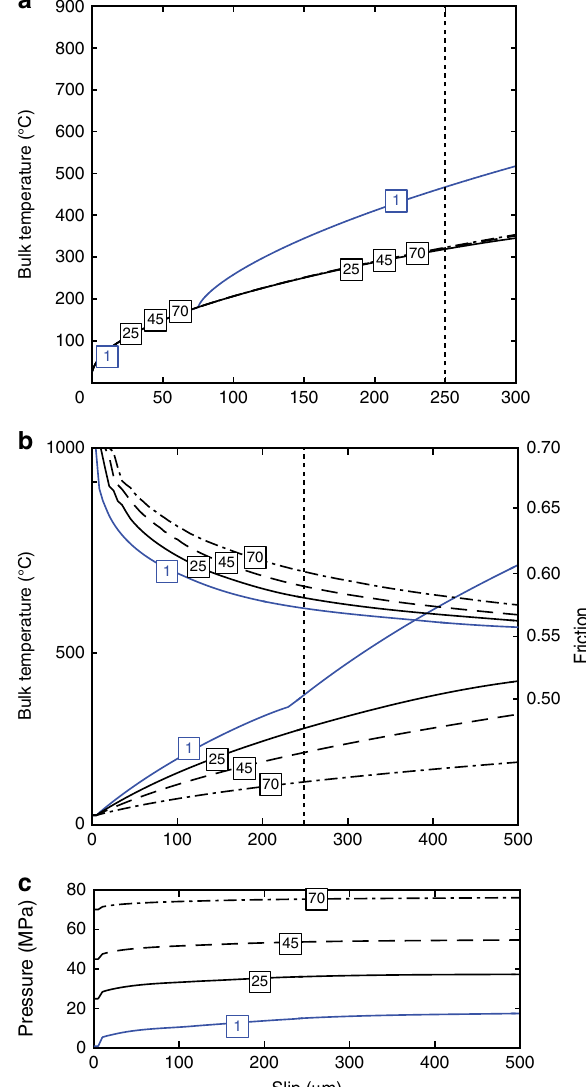
Fig. 5 Bulk fault temperature model at 1 m s − 1 slip rate under experimental shear loading. Blue curves correspond to low fl uid pressure conditions (1 MPa) and black to high fl uid pressures (25, 45 and 70 MPa). Vertical dotted lines show the maximum slip in our experiments. a Bulk temperature reached in the fault ’ s slipping zone during shear heating versus slip under drained conditions (e.g. Methods); each curve corresponds to the labelled fl uid pressure in MPa. b Bulk temperature (left y axis) reached in the fault during shear heating under undrained conditions and the corresponding friction evolution due to TP (right y axis) versus slip (e.g. Methods); each curve corresponds to the labelled fl uid pressure in MPa. c Fluid pressure evolution in the fault ’ s slipping zone during shear heating versus slip for the different initial fl uid pressures labelled in